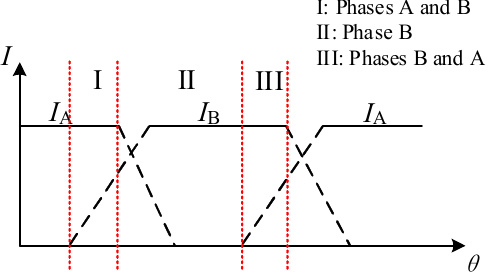
Figure 3. The distribution of conduction interval.